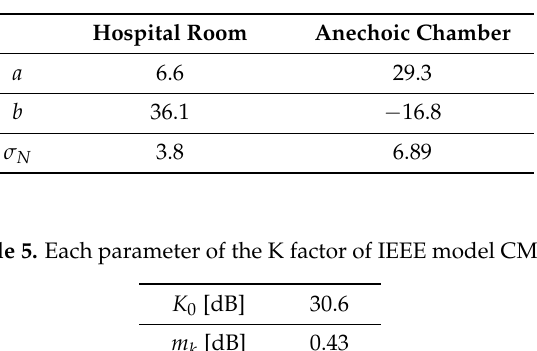
Table 4. Each parameter of the IEEE model CM 3 path loss model.